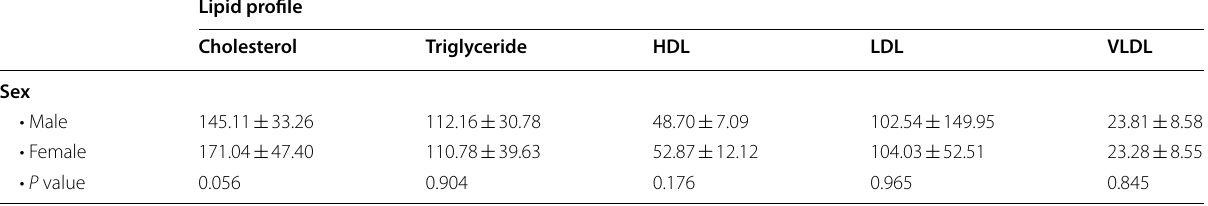
Table 7 Comparison between lipid profiles regarding sex in group A